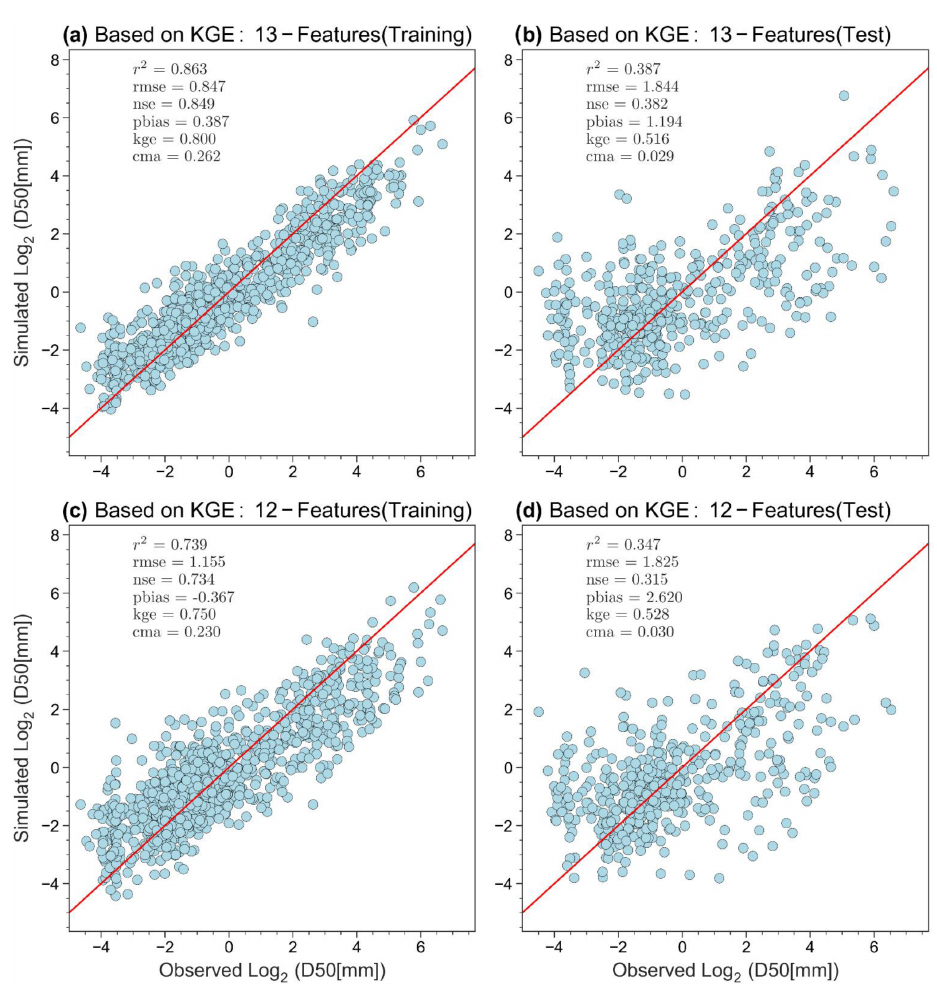
Figure 6. XGBoost model performance with the training (a, c) and testing (b, d) datasets. Comparison of model performances using 13 features (a, b) and 12 features ( c, d ; after removing “Channel_Mean_Slope”).